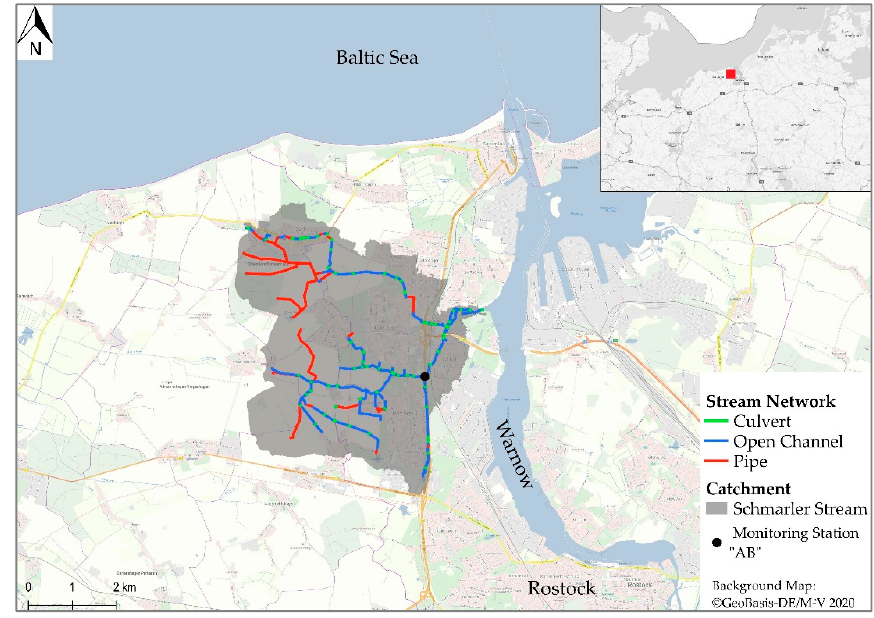
Figure 1. Schmarler stream system and catchment. Table 1. Different types of land use and their area percentage in the Schmarler stream catchment.